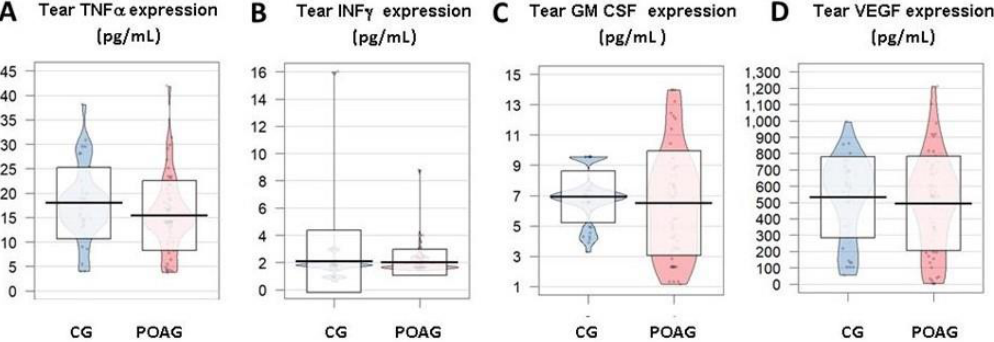
Figure 4. Set of inflammatory mediators TNFα ( A ), INF-g ( B ), GM CSF ( C ) and VEGF ( D )